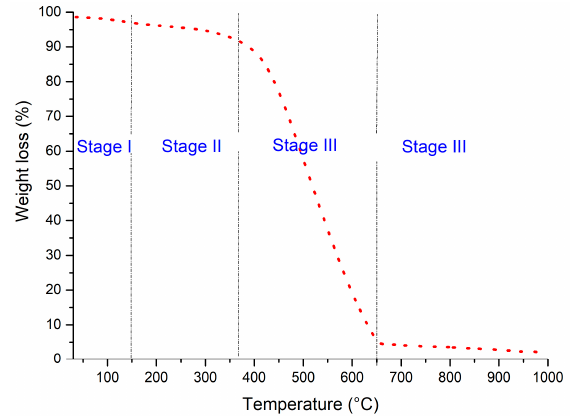
Figure 7. Temperature programmed oxidation (TPO) of the EOP biochar.